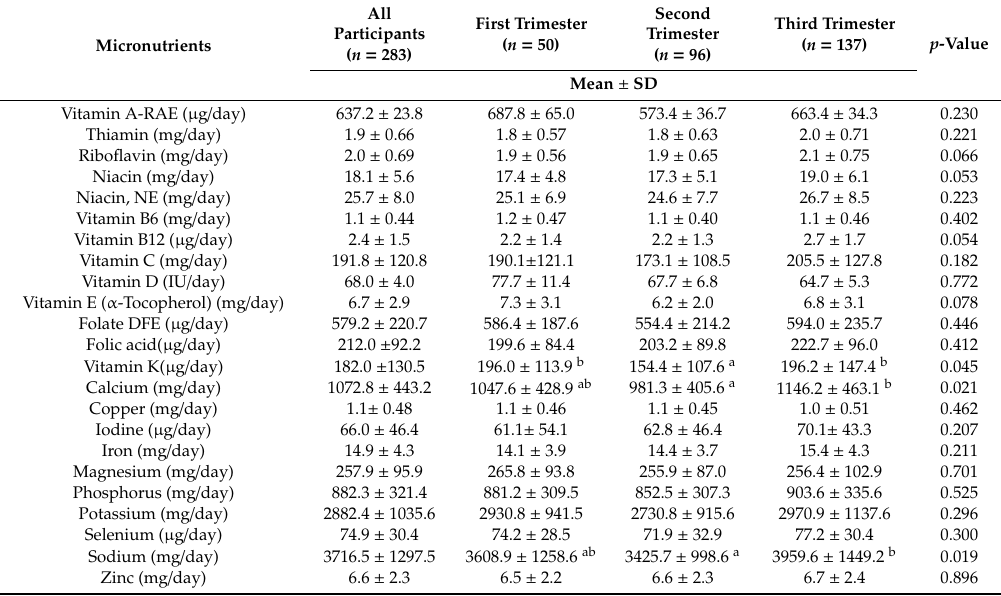
Table 4. The mean daily intake of total micronutrient intakes from food alone estimated by a validated food frequency questionnaire administered to 283 pregnant Jordanian